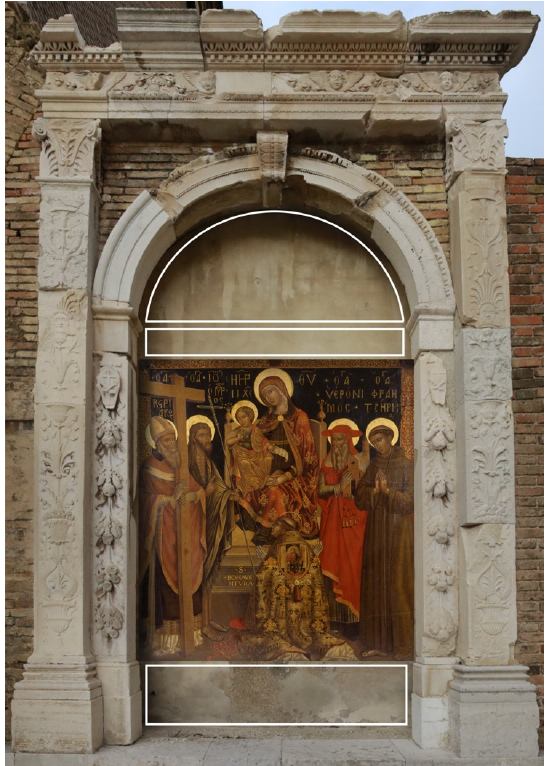
Figure 5. The Altarpiece of Francesco Scottivoli (virtual reconstruction by the author). The icon measures 178 × 160 cm and consists of three pieces of wood attached